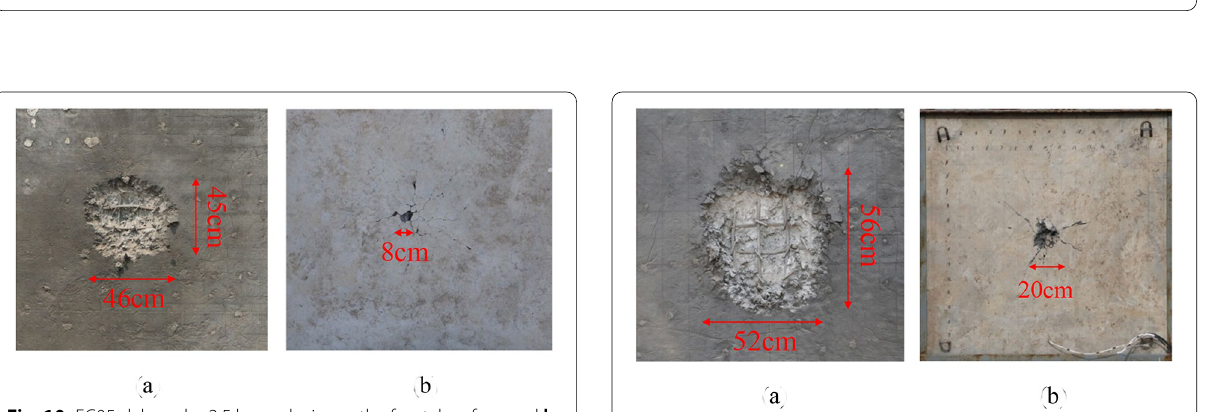
Fig. 11 FC05 slab under 3.6 kg explosion: a the frontal surface and b the back